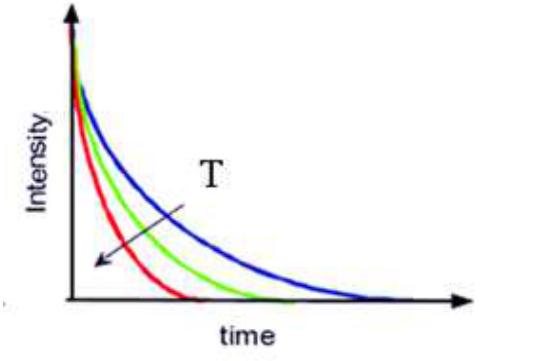
Figure 13. Typical lifetime characteristics with increasing